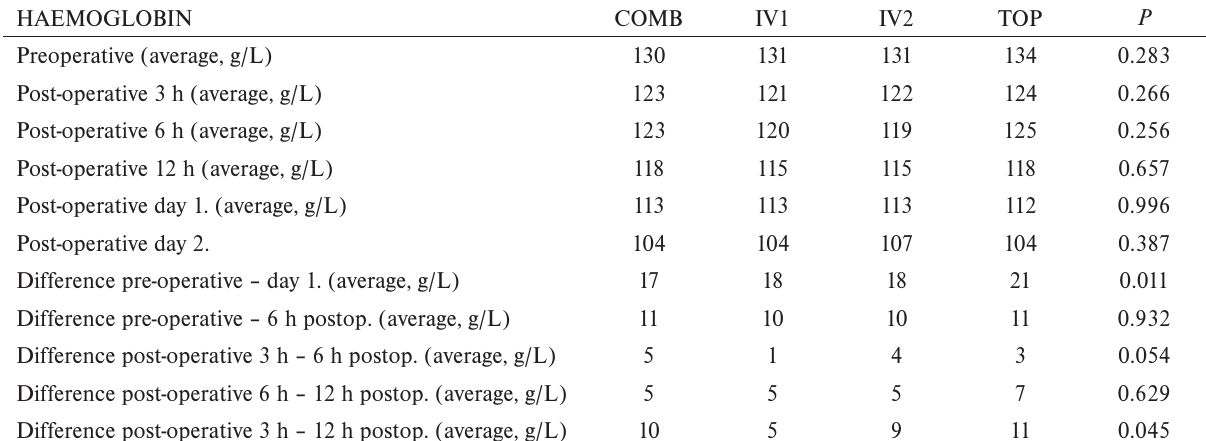
Table 4. Comparison of haemoglobin level, its decrease.